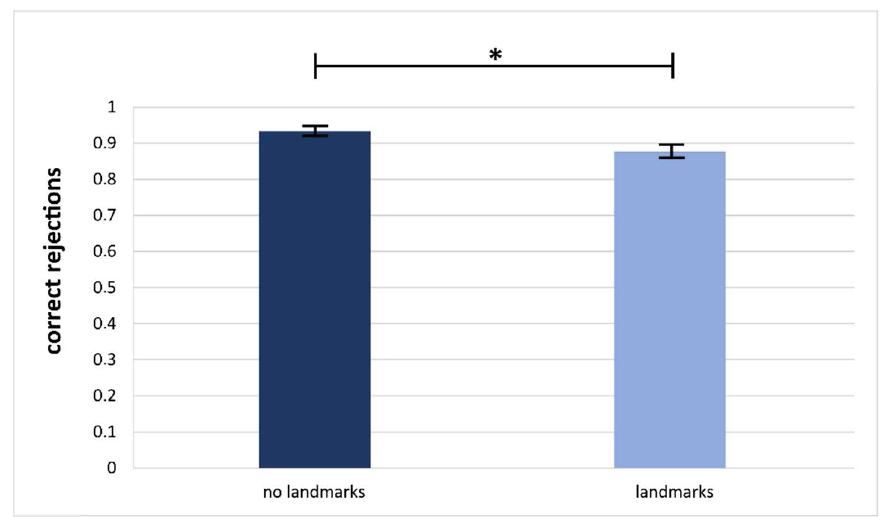
Figure 3. Mean correct rejection difference between the study map landmark conditions. The mean correct rejection of incorrect routes was higher when no landmarks were shown in the study map (M noLandmarks = 0.931, M Landmarks = 0.882, p = 0.028). This picture is different, when it comes to the eye-tracking data. Here, the fixation count differed significantly between the route AOI and the offside route AOI (see Figure 4) both in the reduced maps (M RouteAOI = 42.867, M OffsideRouteAOI = 2.724, W = 1, p < 0.001) and the standard maps (M RouteAOI = 45.506, M OffsideRouteAOI = 36.136, W = 88, p = 0.015). The differences of